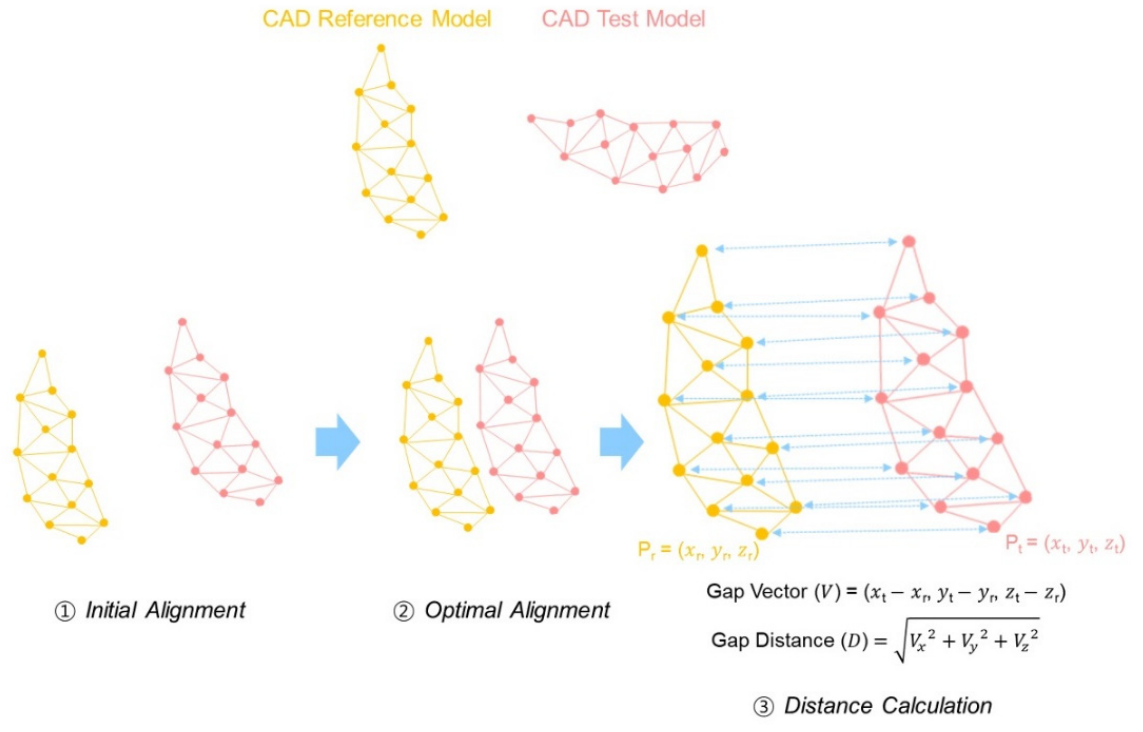
Figure 1. Schematic representation of alignment procedure and distance calculation.